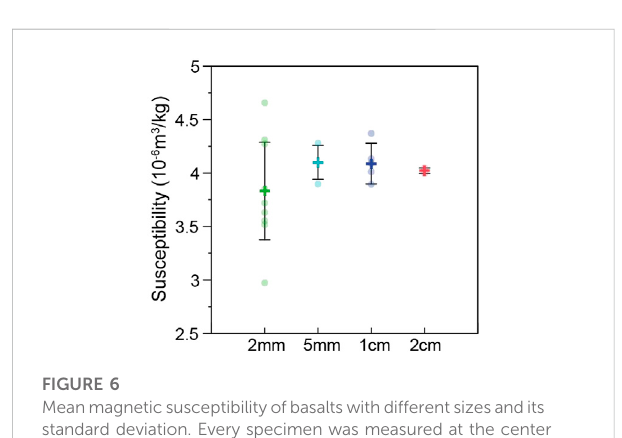
FIGURE 6 Meanmagneticsusceptibilityofbasaltswithdifferentsizesandits standard deviation. Every specimen was measured at the center